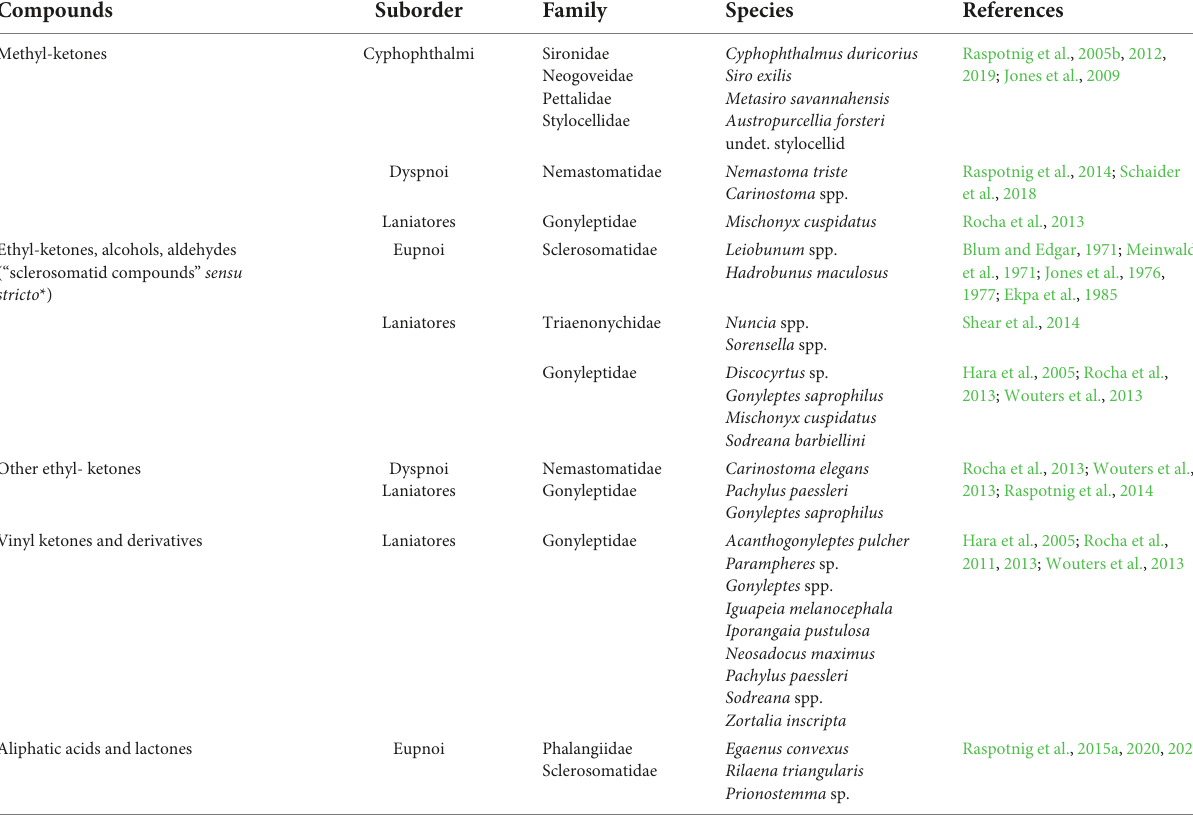
TABLE 1 Acyclic compounds and their derivatives in the scent gland secretions of harvestmen.